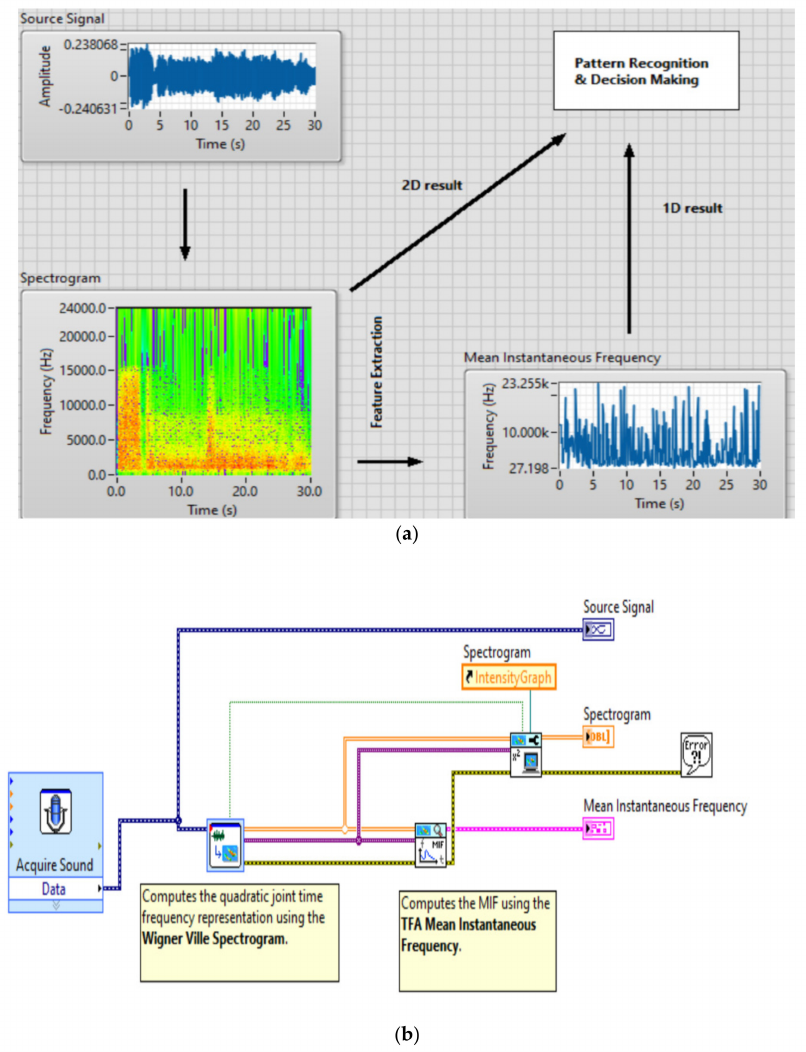
Figure5. TheWigner-VilleanalysisperformedforanacousticsignalgeneratedbyanUAV,GUIinterfaces ( a ) and software implementation ( b